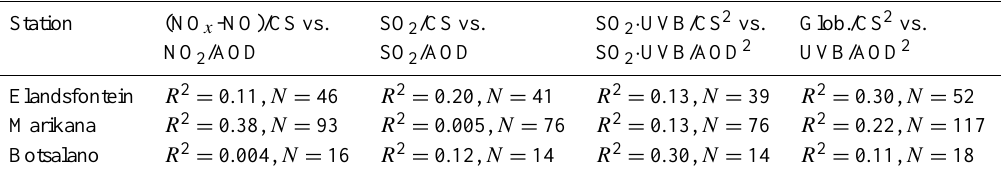
Table 2. Correlations between in-situ- and satellite-based proxies. The number of coincident observations is denoted with “ N ”. Scatter plots for each of the case are provided as a Supplementary Material. Station (NO x -NO)/CS vs. SO 2 /CS vs. SO 2 · UVB/CS 2 vs. Glob./CS 2 vs. NO 2 /AOD SO 2 /AOD SO 2 · UVB/AOD 2 UVB/AOD 2 Elandsfontein R 2 = 0 . 11, N = 46 R 2 = 0 . 20, N = 41